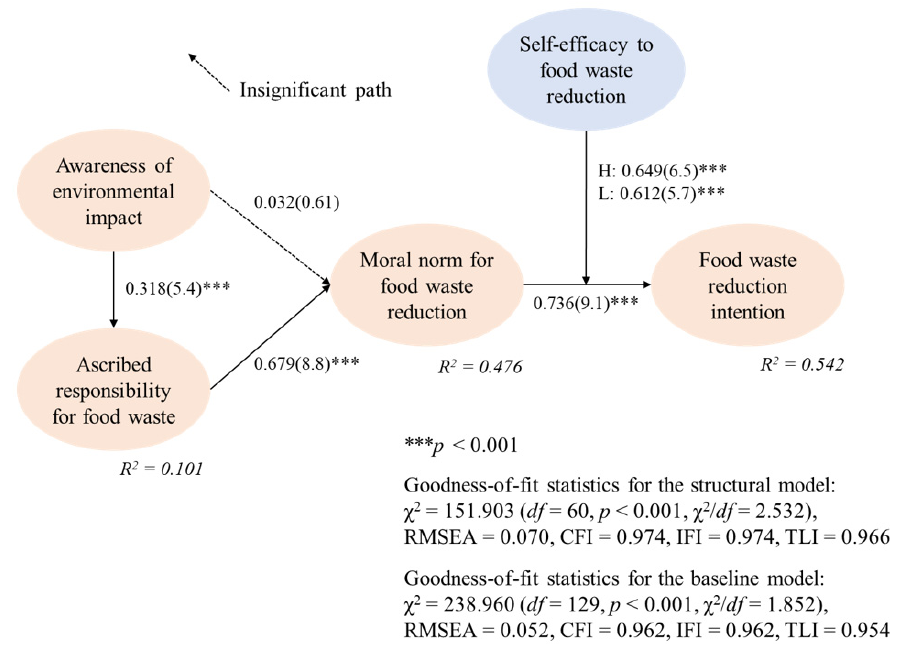
Figure 2. The structural model results.